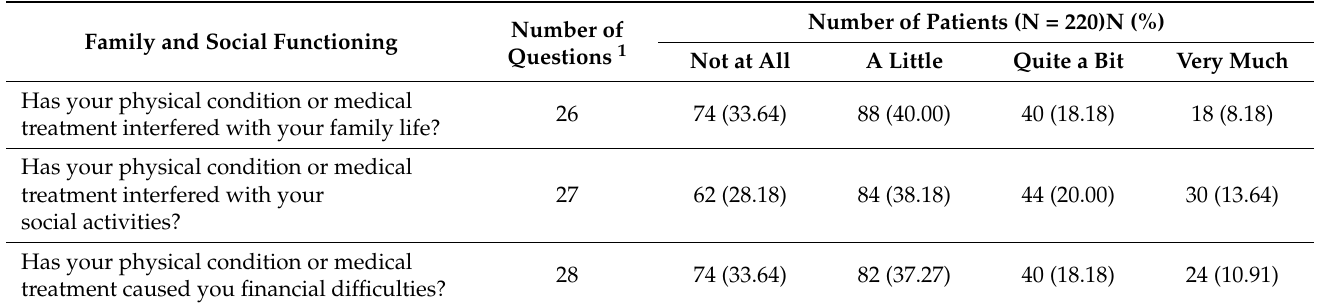
Table 5. Assessment of family and social functioning made by the